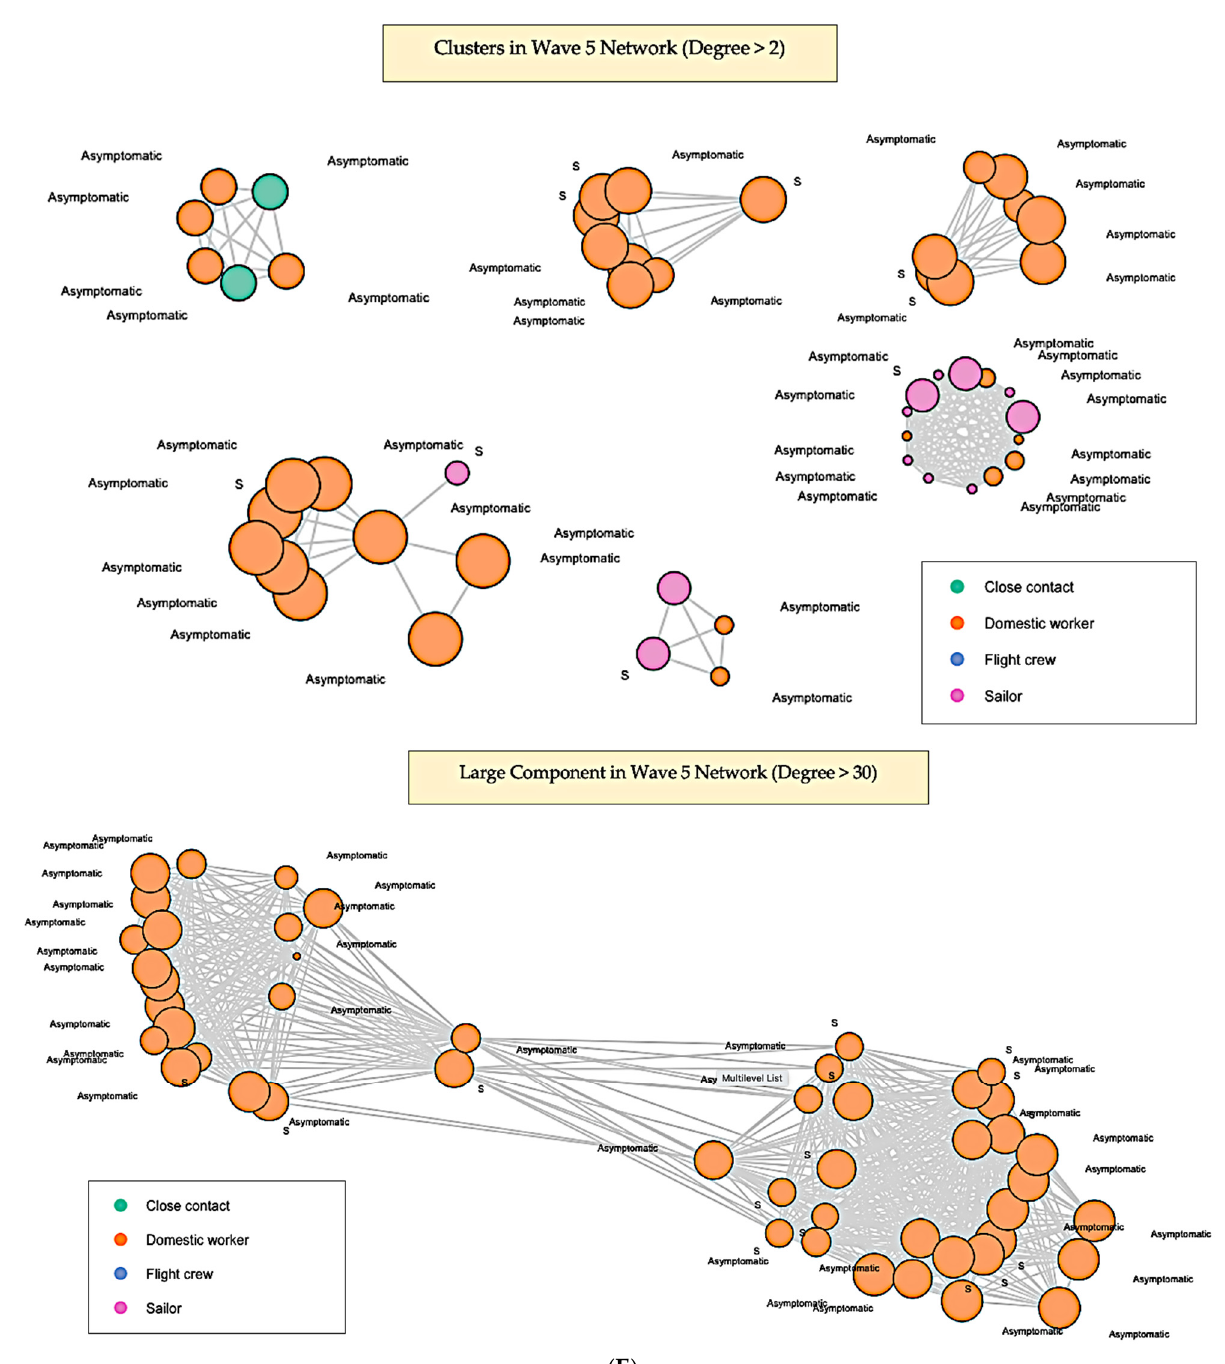
Figure 2. ( A ) Clusters in Wave 1 Network (Degree > 2); ( B ) Clusters in Wave 2 Network (Degree > 10); ( C ) Clusters in Wave 3 Network (Degree > 5); ( D ) Clusters in Wave 4 Network (Degree > 10); ( E ) Clusters & Large Components in Wave 5 Network.